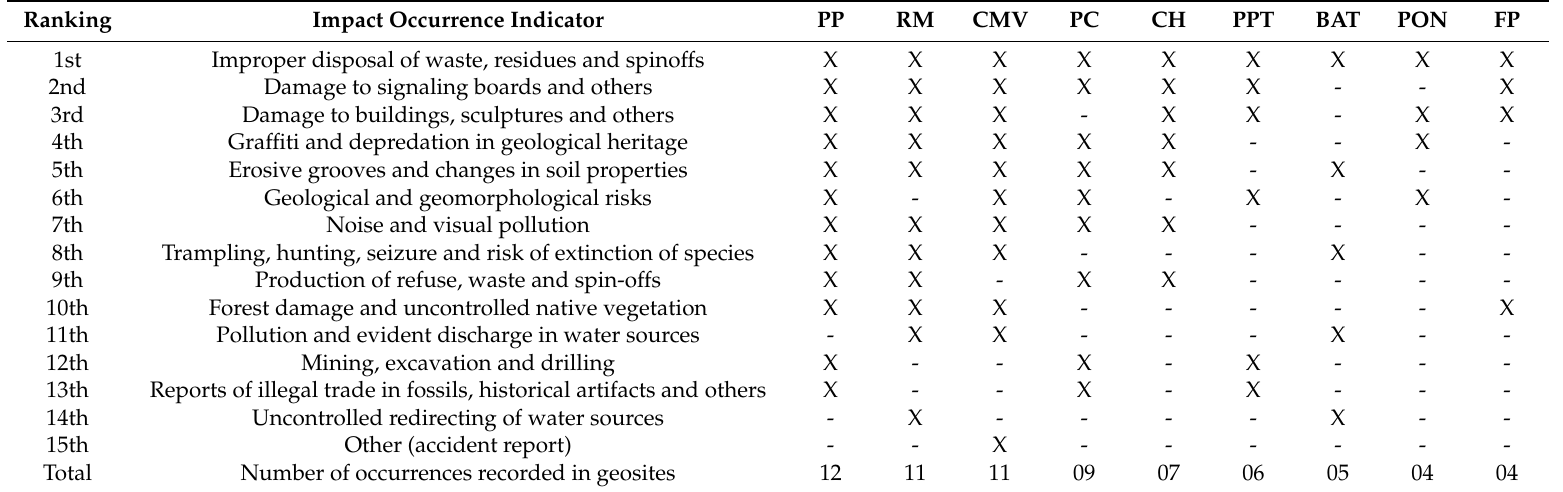
Table 4. Tabulation of evident impacts on Araripe geosites (PP, Ponte de Pedra; RM, Riacho do Meio; CMV, Cachoeira de Miss ã o Velha; PC, Pedra Cariri; CH, Colina do Horto; PPT, Parque dos Pterossauros; BAT, Batateiras; PON, Pontal de Santa Cruz; FP, Floresta